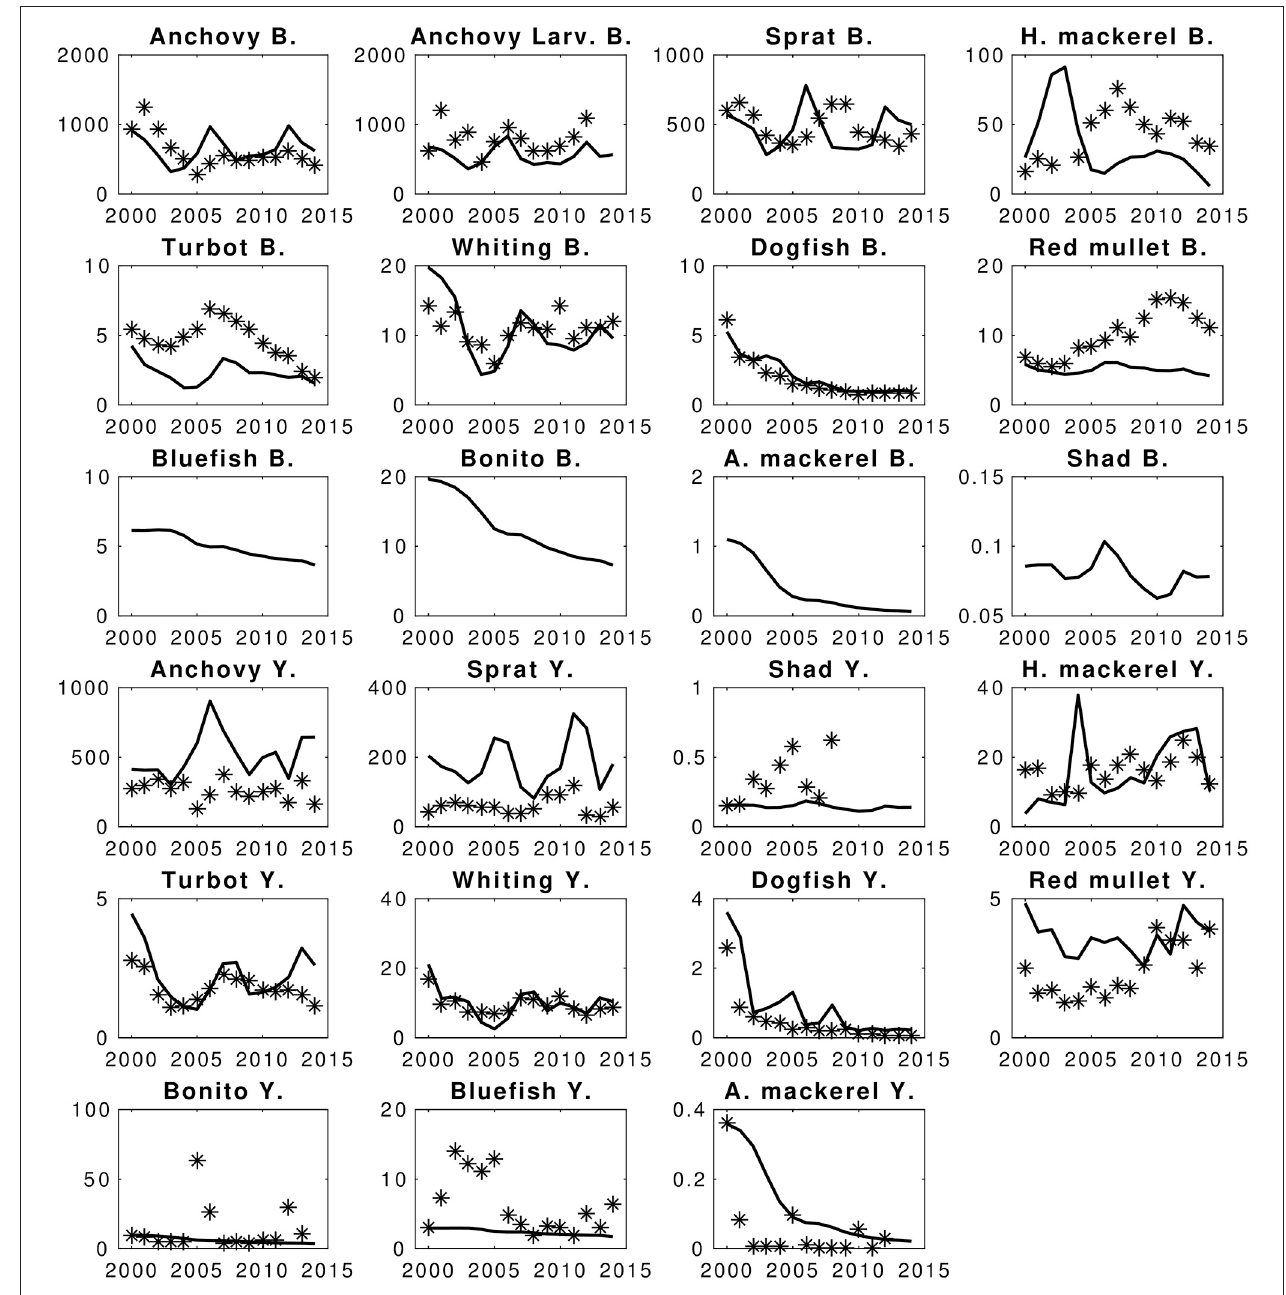
FIGURE 7 | Hindcast simulation results of the EwE fish model and fits to the statistical catches and conventional statistical stock assessment predictions. Stars denote the compared data and lines are the simulation results. X-axis denote years and Y-axis denote catches (Y.) and biomasses (B.) The units are in kilotons.